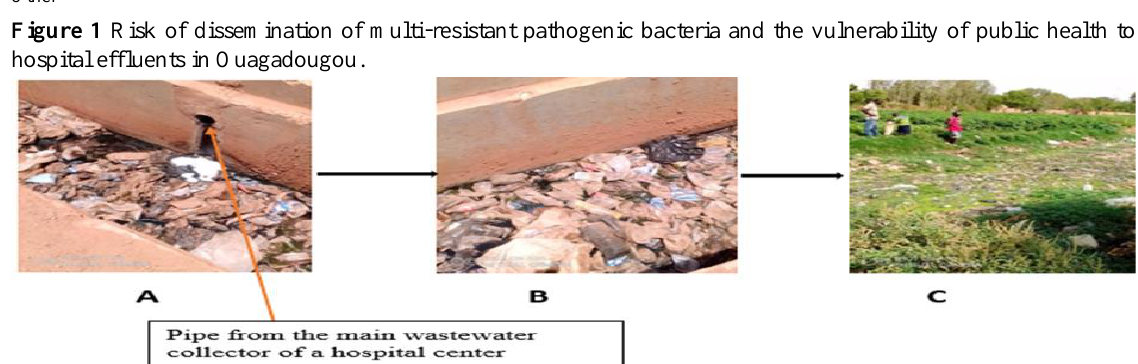
Figure 1 Risk of dissemination of multi-resistant pathogenic bacteria and the vulnerability of public health to hospital effluents in